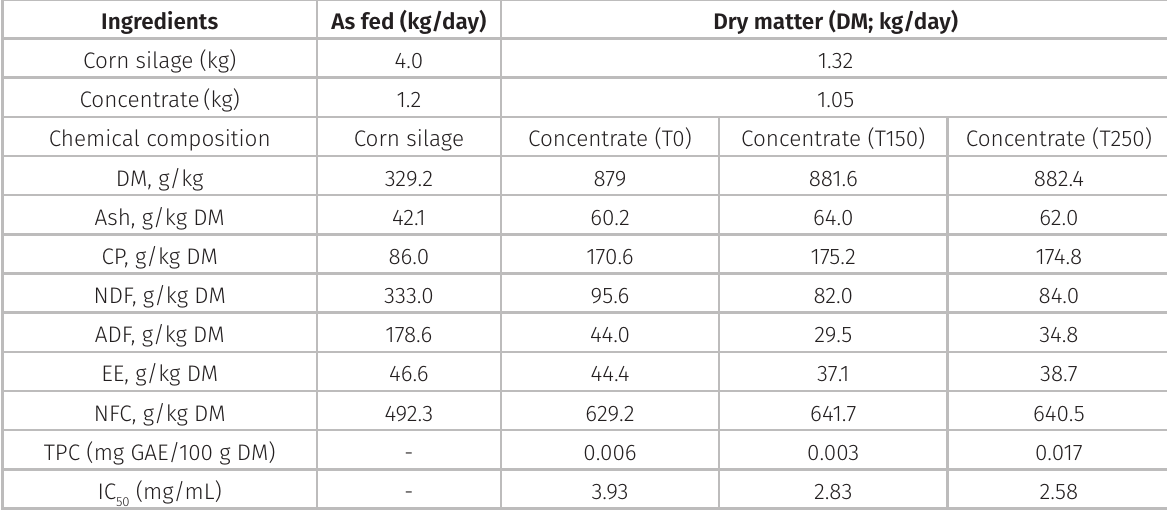
Table I. Ingredients and chemical composition of ingredients and experimental diets.